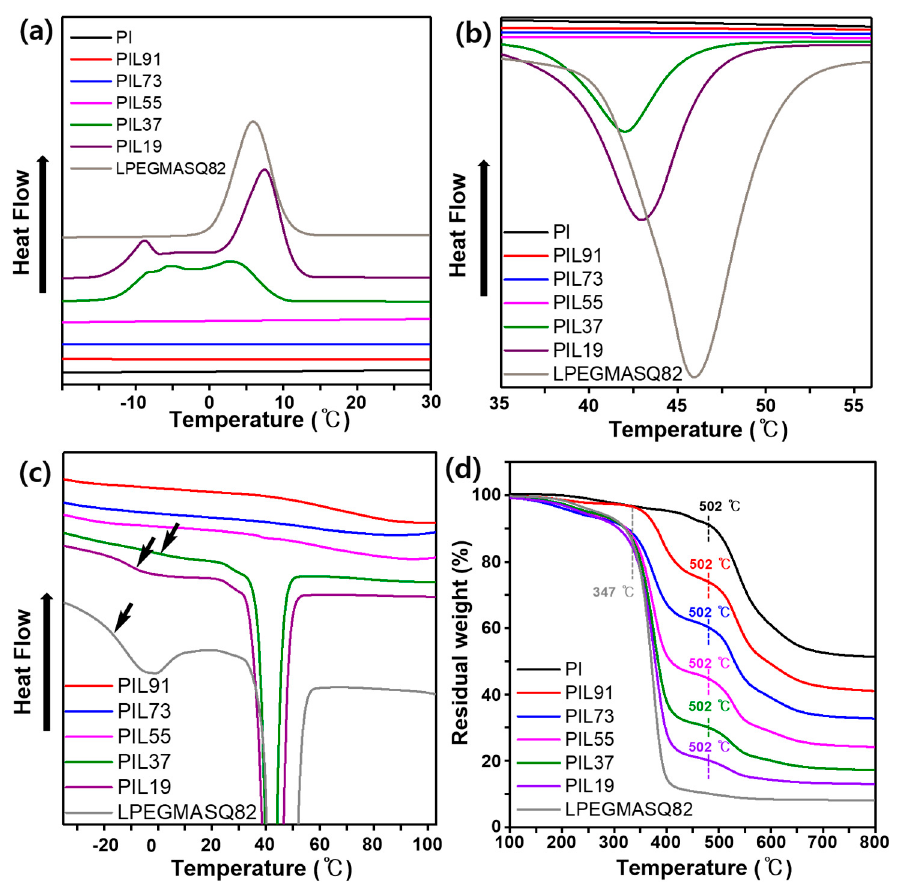
Figure 4. DSC thermograms of hybrid composites showing expanded views of: ( a ) T c , ( b ) T m , and ( c ) T g , and thermogravimetric analysis (TGA) of hybrid composites ( d ). Materials 2020 , 13 , x FOR PEER REVIEW